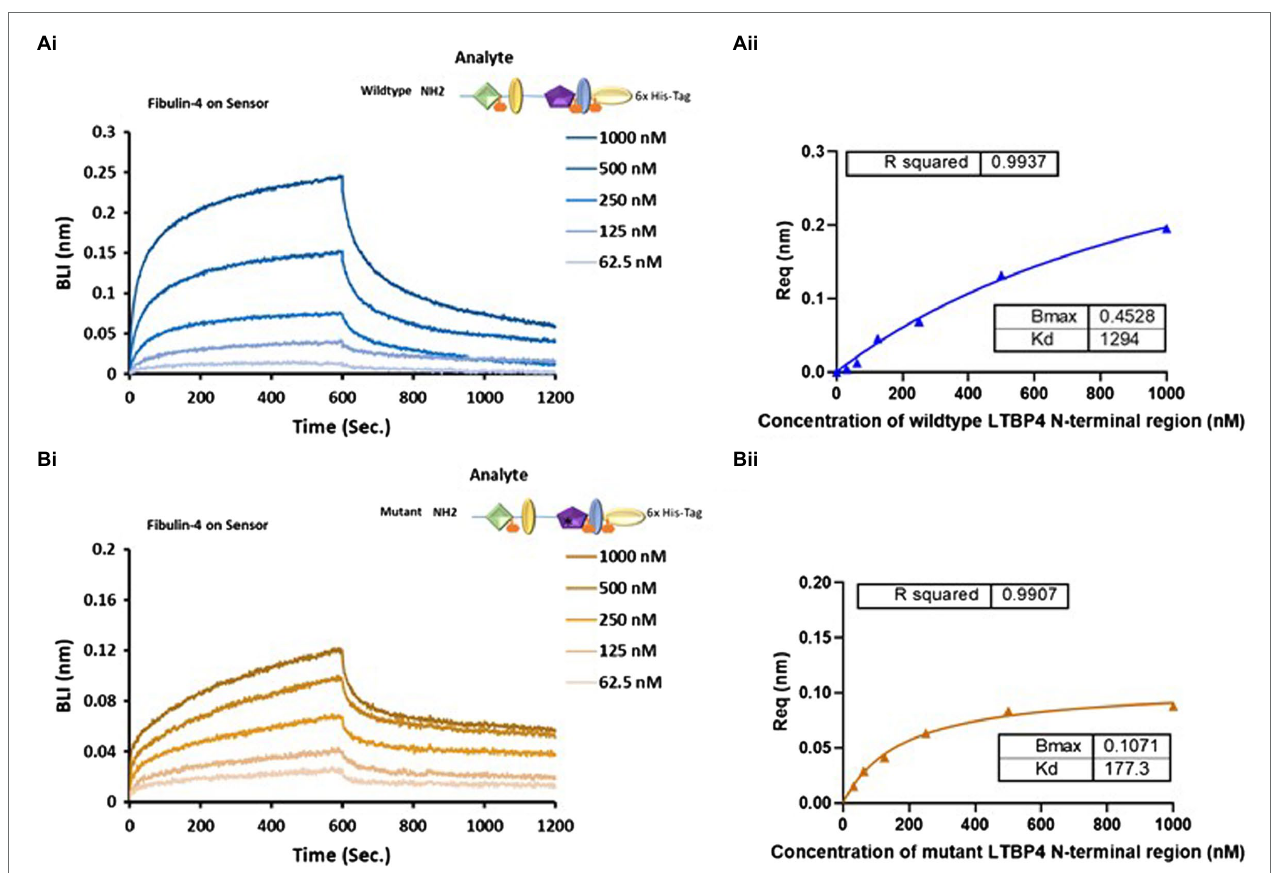
FIGURE 6 | The impact of ARCL1C causing point mutation on LTBP4 N-terminal interaction with fibulin-4. Binding studies using BLI were performed using OctetRED analysis. Representative Octet sensorgrams showing both (A) (i) NWT and (B) (i) C274G at a range of concentrations (1000–62.5 nm) bind to immobilised fibulin-4. The binding affinity KD was determined by steady state (equilibrium) for (A) (ii) the wild type and (B) (ii) C274G. All experiments were performed in at least duplicate and representative results are